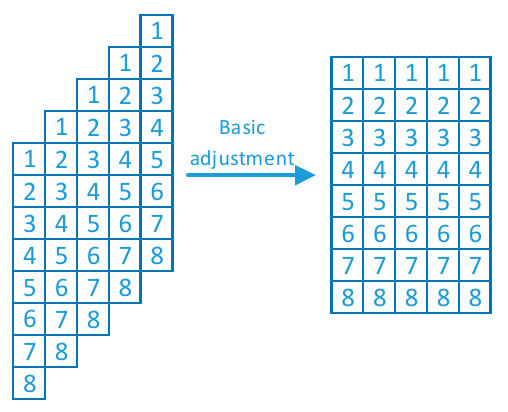
Figure 5. The process of basic adjustment using Equation (4).